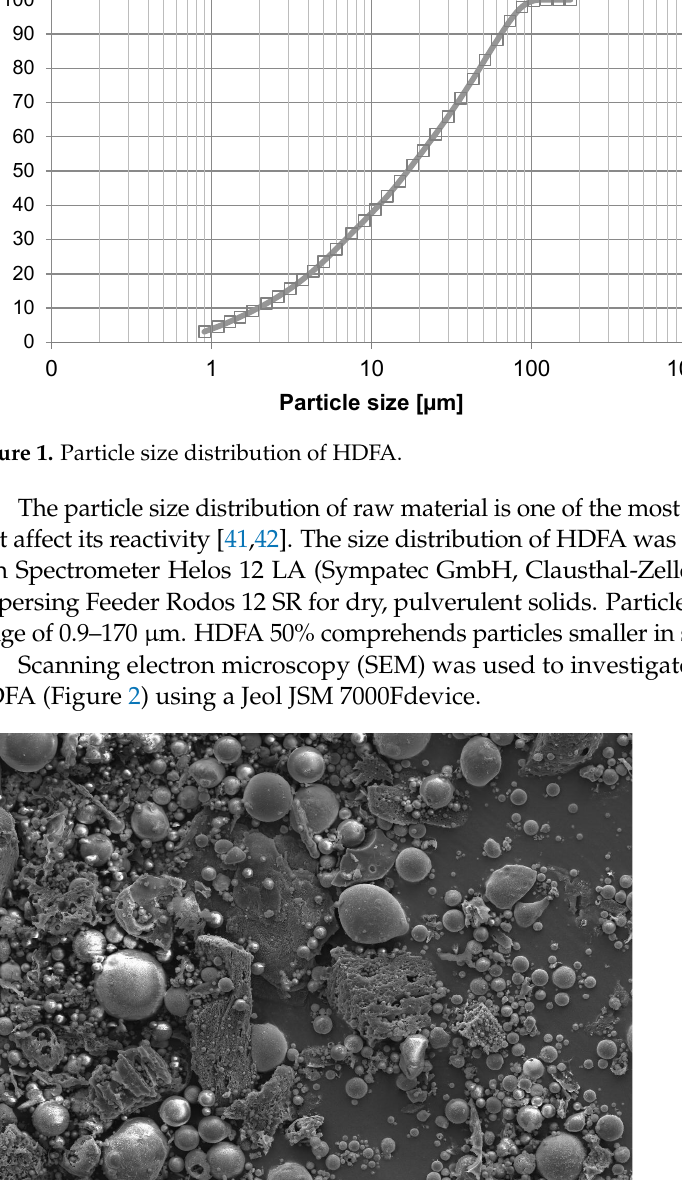
Figure 2. SEM picture of HDFA.